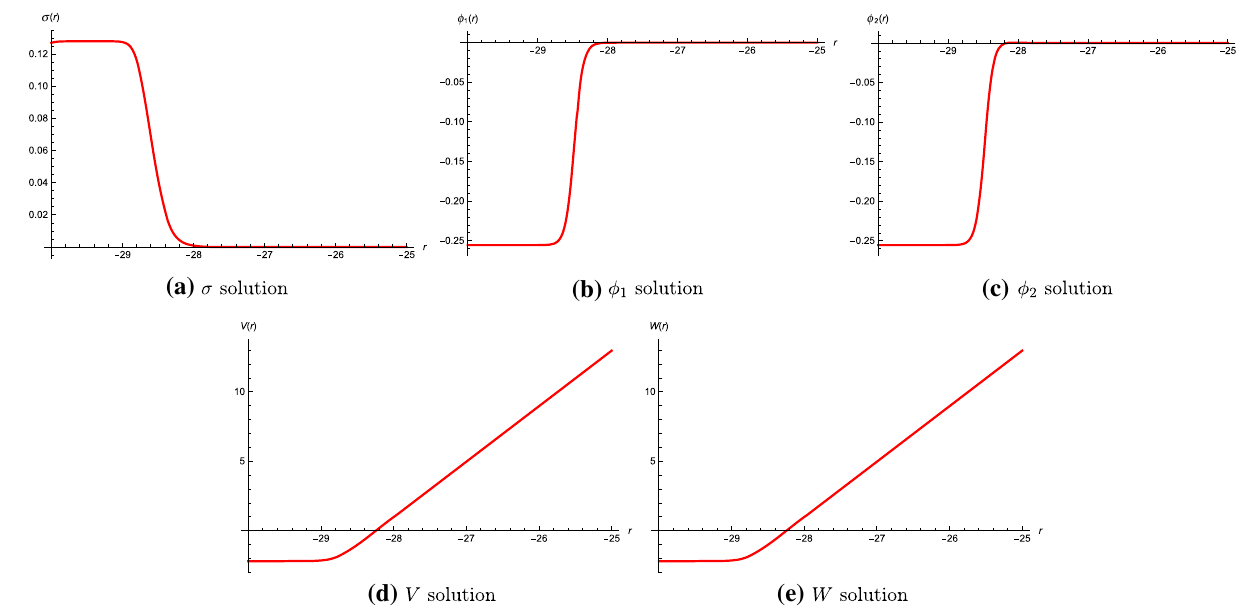
Fig. 6 An RG flow from SO ( 4 ) N = ( 1 , 0 ) SCFT in six dimensions to two-dimensional N = ( 2 , 0 ) SCFT with SO ( 2 ) diag symmetry dual to